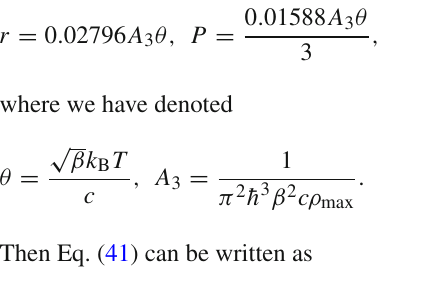
Fig. 5 Variations of the functions ˜ T 2 I (dotted curve) (right